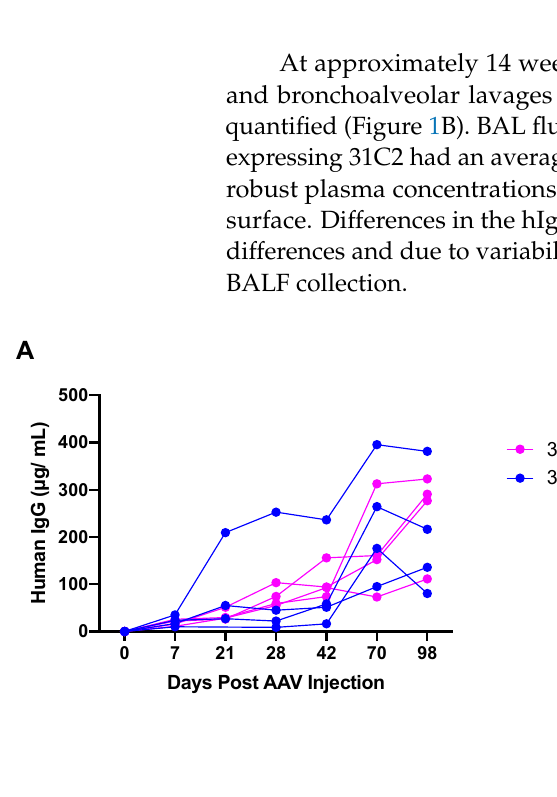
Figure 1. Evaluation of vectorized 31C2 monoclonal antibody. ( A ) 6-week-old male and female BALB/c mice ( n = 4) were administered 2 × 10 10 VG of AAV-mAb and plasma was monitored for hIgG expression over a period of 14 weeks. ( B ) BALF was collected at endpoint and hIgG was quantified. Data are represented as the mean ± standard deviation.